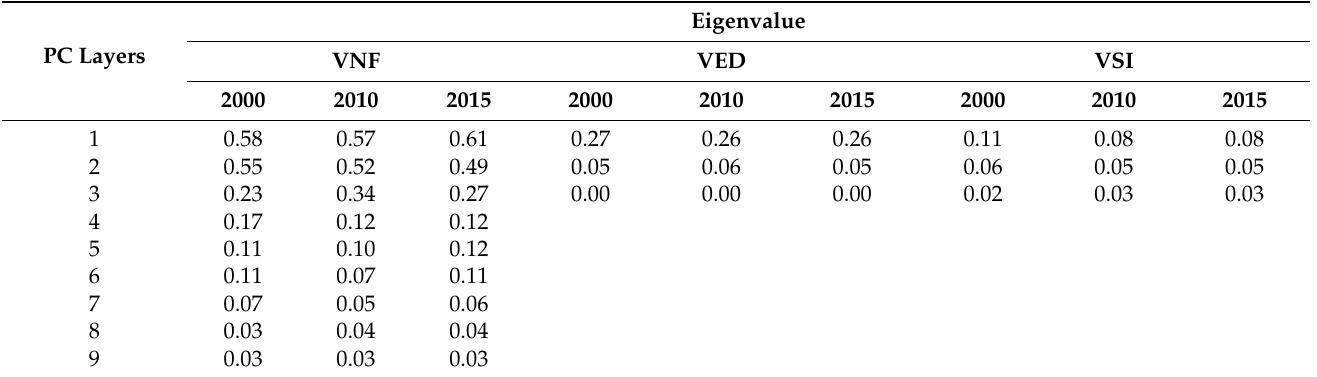
Table 1. SPCA results of VNF, VED and VSI from 2000 to 2015 ( × 10 − 2 ).